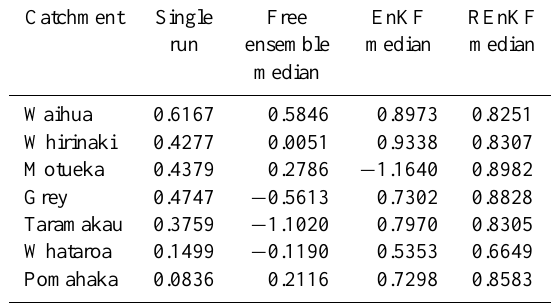
Table 3. Nash–Sutcliffe score for single model run and ensemble median (free-running, EnKF and REnKF), calculated for time pe- riod 1 April 2011–31 March 2012.